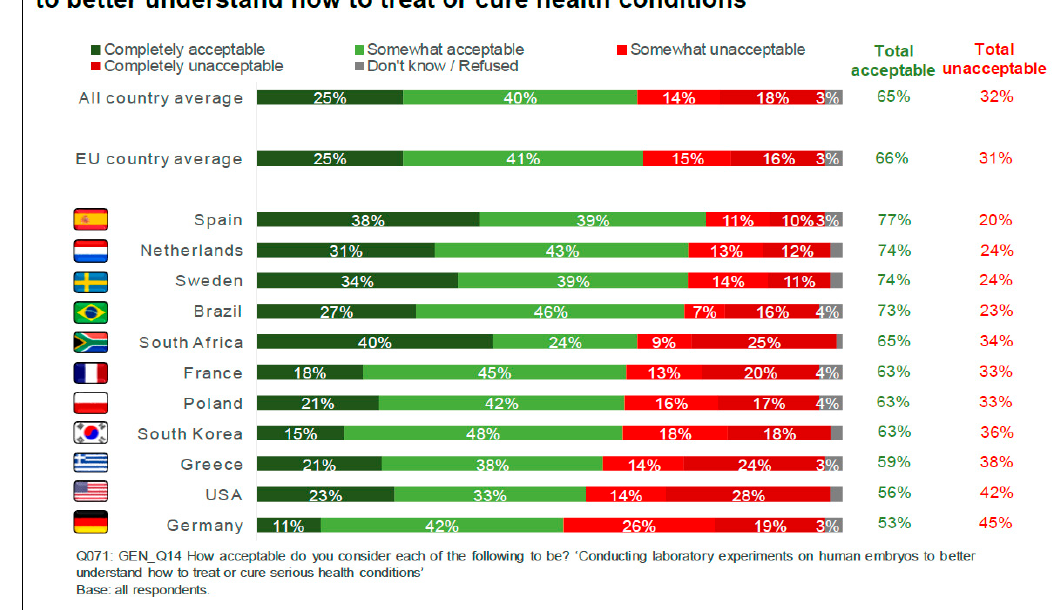
Scheme 4. “Acceptability of conducting laboratory experiments on human embryos to